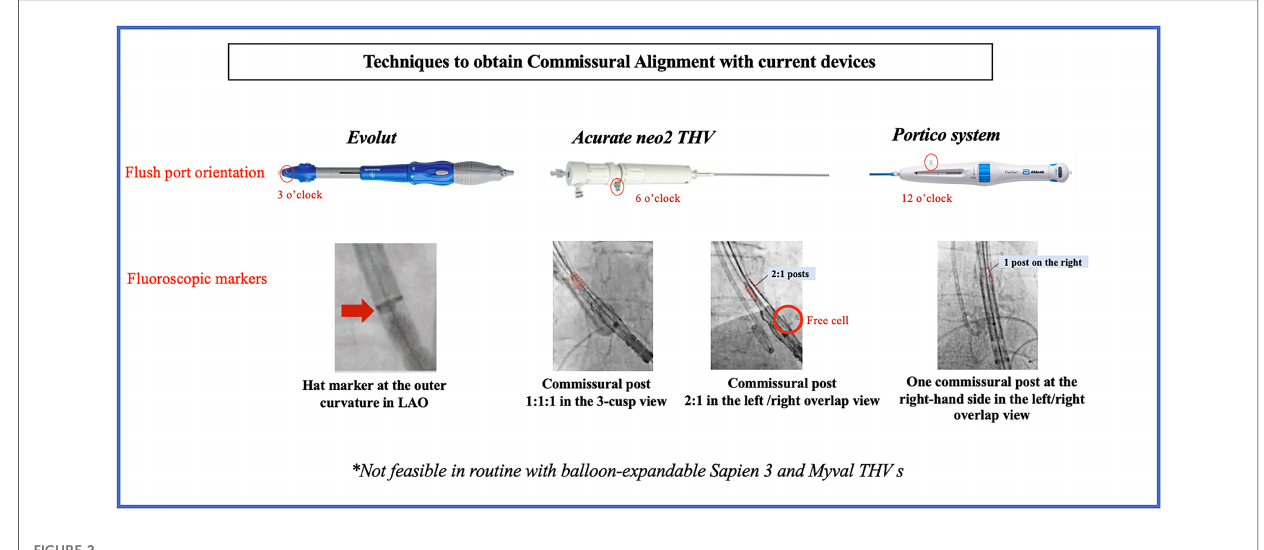
FIGURE 2 Techniques to obtain commissural alignment with current devices. LAO, left anterior oblique; THV, transcatheter heart